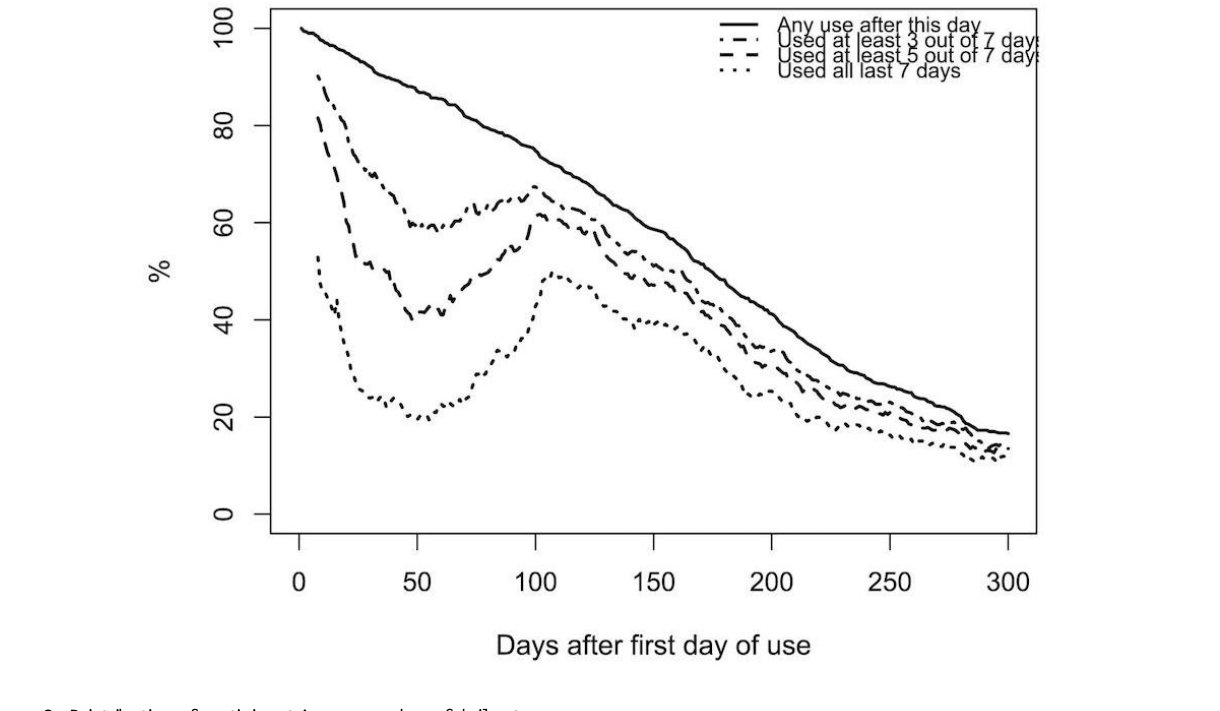
Figure 2. Usage decline over time. The horizontal axis shows the number of days since the first day of use. The percentage of participants who used the activity tracker for any number of days after a particular day is indicated with a solid line. The other lines indicate habitual use: the percentage of participants who used the tracker for at least 3, 5, and 7 days in the preceding 7 days. Note that this includes participants who stop using the tracker and later start using it again. The early dip in use is due to the summer holiday.